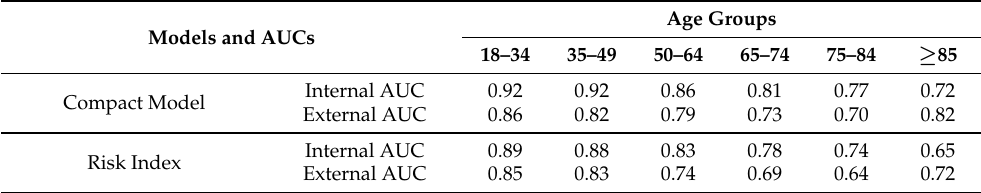
Table 4. Age-specific AUCs of